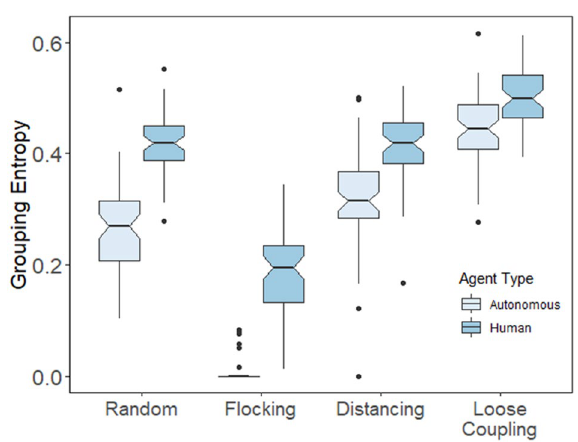
Figure 8. Entropy values by movement condition (Random, Flocking, Distancing, and Loose coupling) for human players (Human) versus simulated agents (autonomous) in the